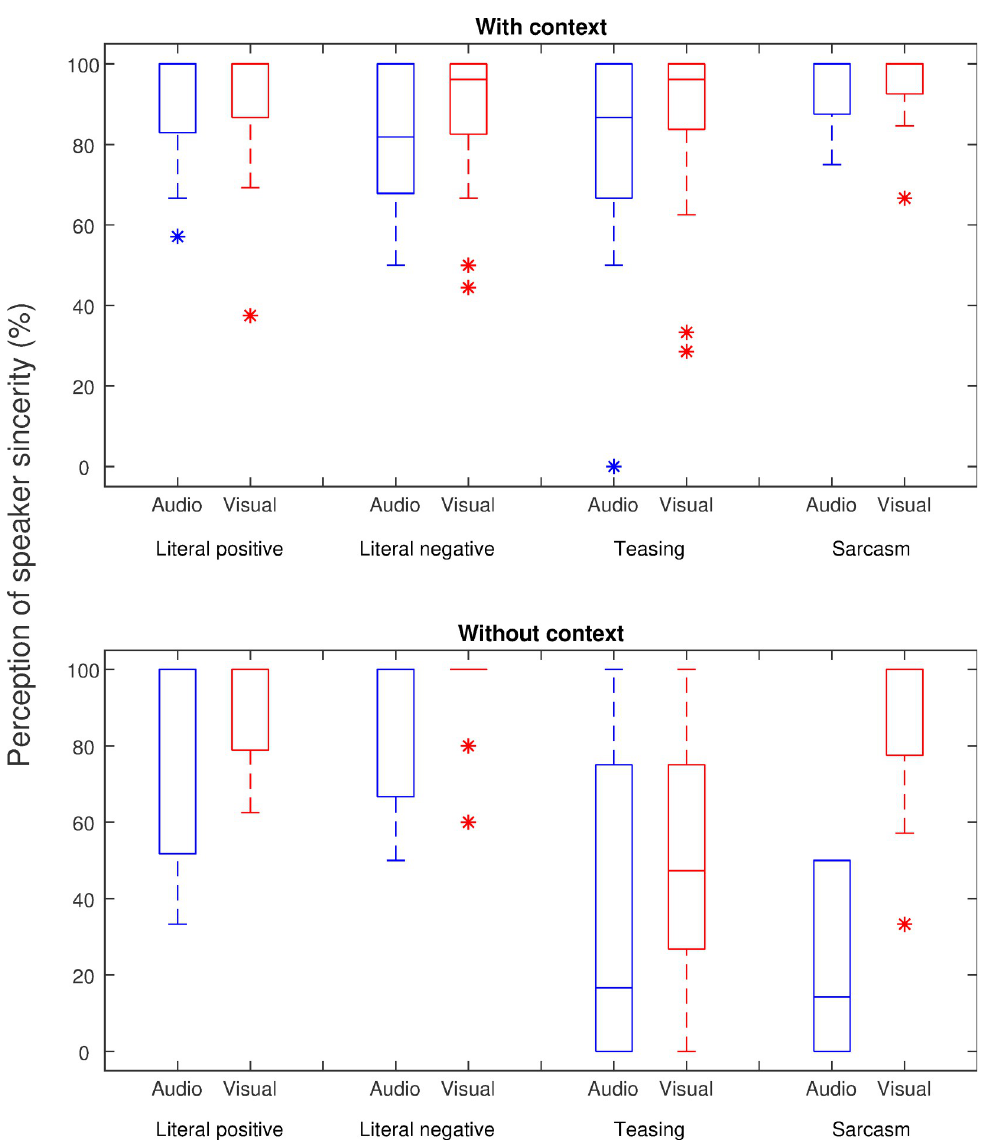
Fig 2. Box plot of perception of speaker’s intentions collapsed across subjects. The top panel shows performance with context, and the bottom panel shows performance without context. Percent correct scores were calculated based on the number of correctly perceived intentions relative to the number of correctly perceived contents. Bars represent group medium. Asterisks show outliers.